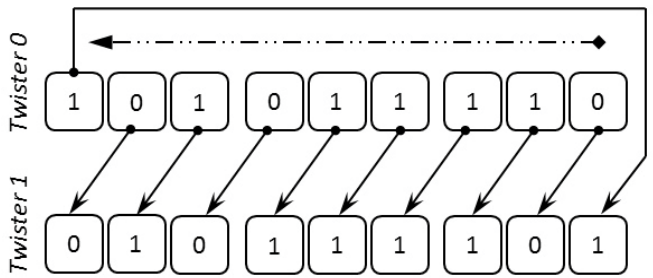
Figure 8. Diagram of circular twister algorithm.